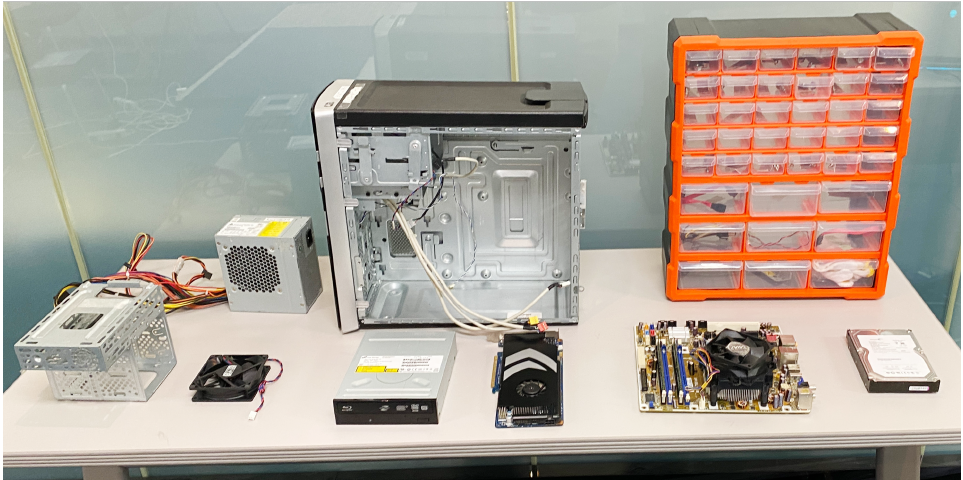
Figure 30. Task 2: PC assembly task.